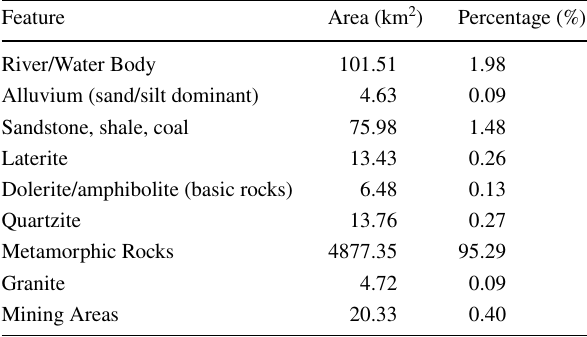
Table 5 Area statistics of lithology